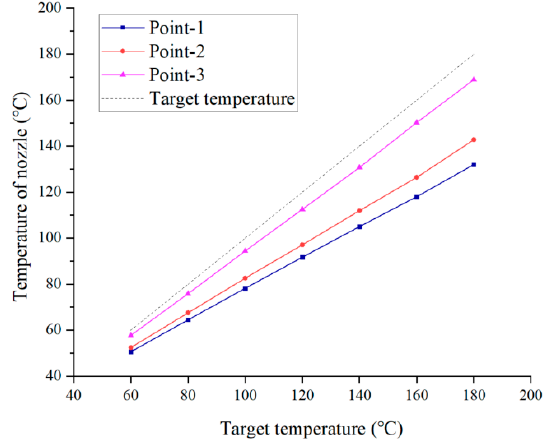
Figure 5. Steady-state temperatures with varying target temperatures.